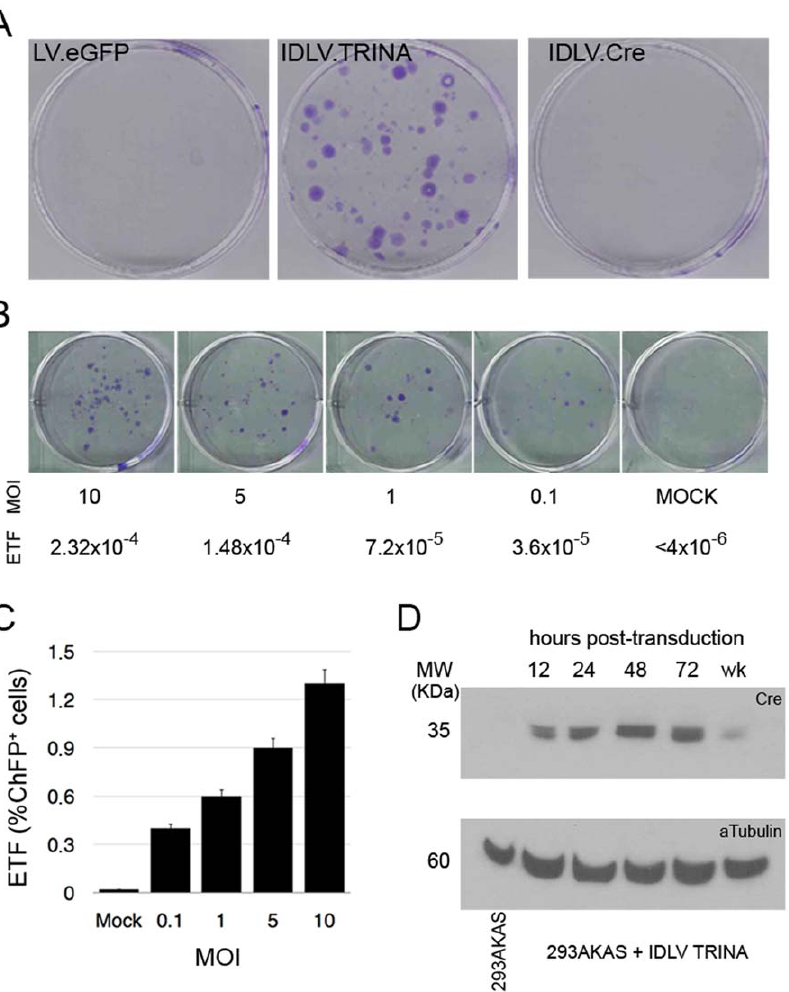
Figure 3. Randomly chromosomal integrated copies of the genetic landing pad KAS are targeted by IDLV expressing the TRINA cassette. HEK293A cells resistant to G418 (293AKAS) were pooled and transduced with low MOI (2 transduction unit/cell) of IDLV-TRINA. (A) Transduced cells were selected with hygromycin and the colonies counted. The figure shows stained plates after selection of cells MOCK-transduced (LV.eGFP, left) or transduced with IDLV-TRINA (center) or IDLV-Cre (right). (B) Quantification of RMCE frequency in 293AKAS cells by culturing under selection conditions with hygromycin upon transduction at different MOI with IDLV-TRINA . (C) Quantification of RMCE frequency in 293AKAS cells by FACS analysis of ChFP + upon transduction at different MOI with IDLV-TRINA as in B. Triplicate cultures were transduced, FACS analyzed in triplicate. Average + / 2 SD is represented. (D) Western blot to detect cre expression in pooled 293AKAS cells at different points after transduction with IDLV.TRINA (MOI 2 TU/cell). The alpha-tubulin protein was used as a loading control (bottom panel). Results in A and C are from one representative experiment out of three. ETF: Effective Targeting Frecquency: ratio between hygro R (B) or ChFP + (C) and the number of total G418 R cells plated for